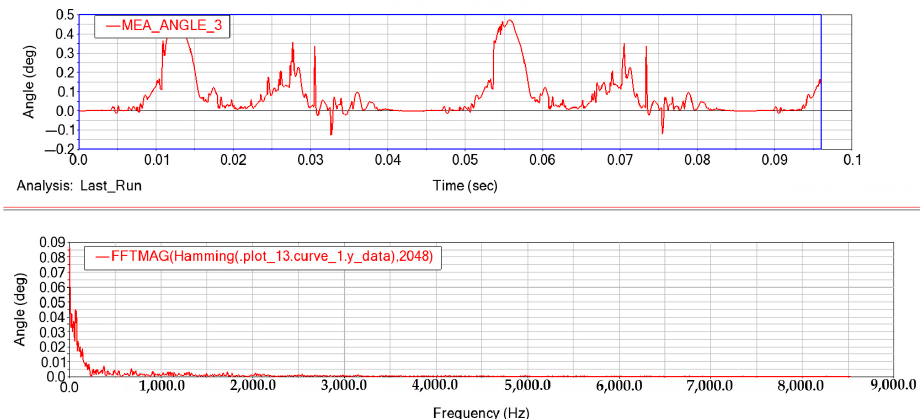
Figure 31. The 1400 r/min free end torsional vibration.